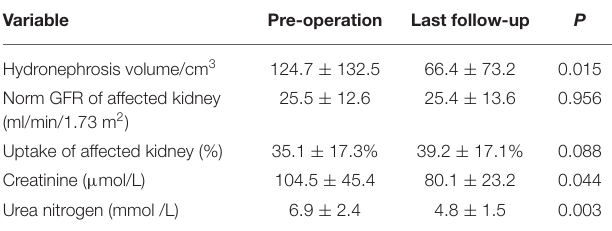
TABLE 3 | Long-term treatment outcomes of the